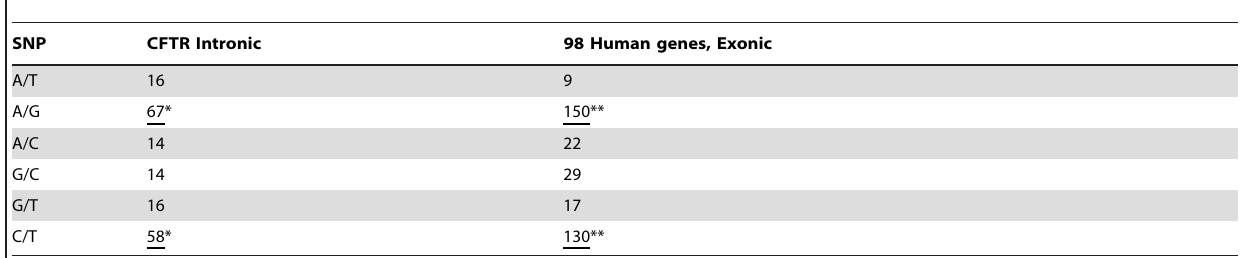
Table 1. Transition Bias in Human